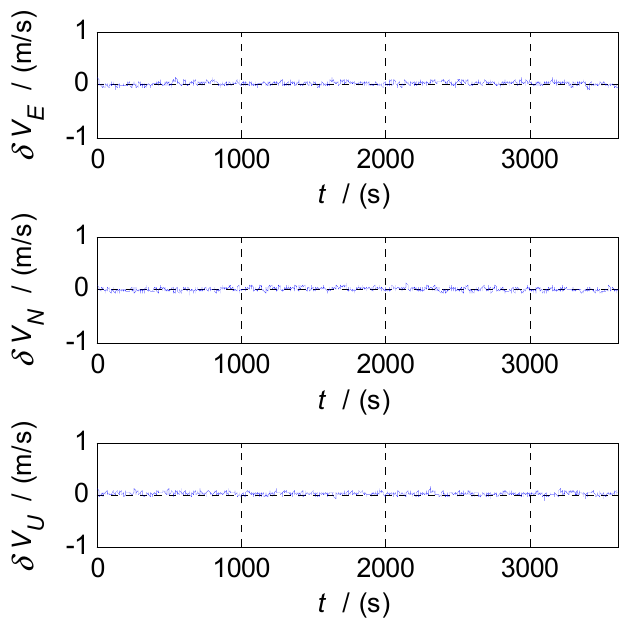
Figure 14. Velocity errors of SINS / CNS / GPS integration using CF.